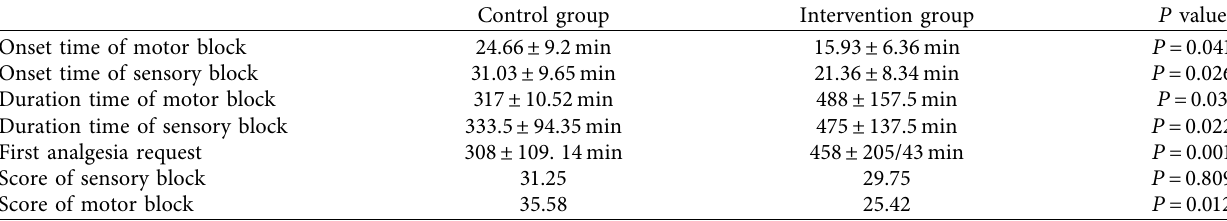
Table 2: Patients’ supraclavicular block characteristics in two groups.